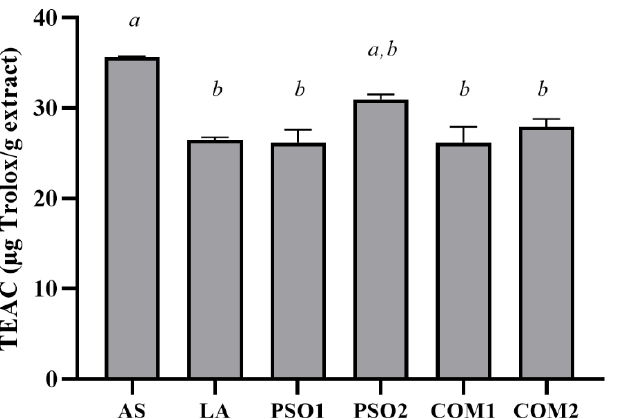
Figure 2. ABTS ● + inhibitory effect of pumpkin seed oil samples (PSO1, PSO2, COM1, COM2), linoleic acid (LA), and ascorbic acid (AS). Data obtained from triplicate and three independent experiments are expressed as mean ± SD. The letters, a and b , presented significant differences among samples in each experiment, p < 0.05.